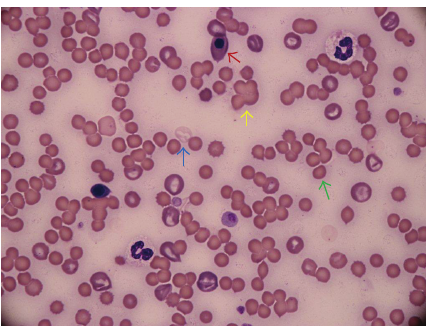
Figure 2: Peripheral blood smear. The orange arrow shows an agglutination that appears as irregular clusters of red blood cells. The blue arrow shows a ghost cell that appears as a very pale small blood cell. The green arrow shows a spherocyte that is a smaller cell that lacks central pallor. The red arrow shows a nucleated red blood cell with the round nucleus and condensed chromatin. Modified Wright × 50 objective. No hemorrhages was observed by owners and thorax X- Ray and abdominal ultrasound were